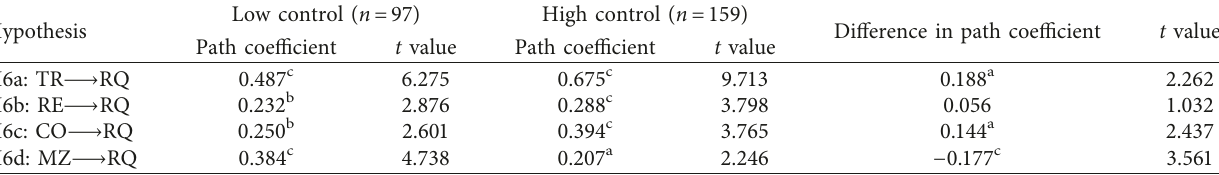
Table 6: PLS analysis of different levels of contractual control.